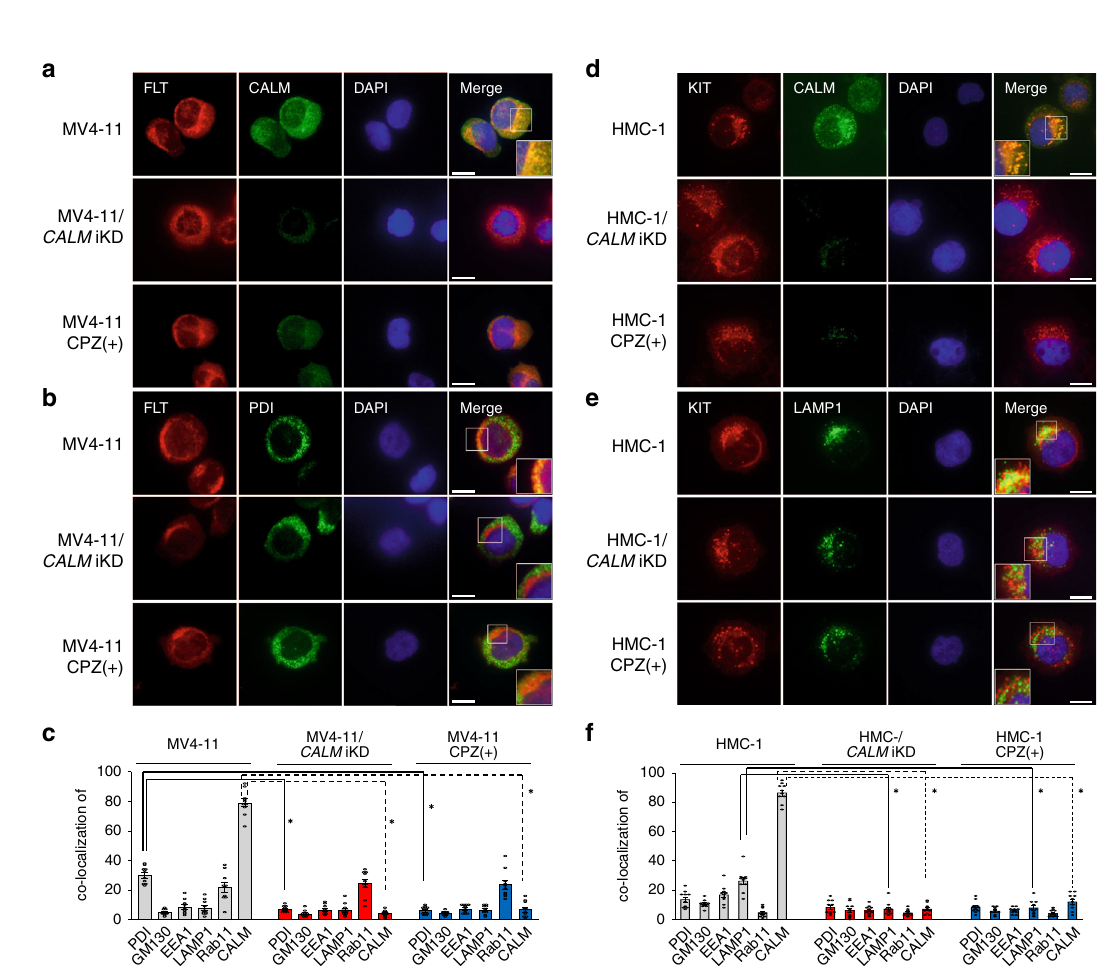
Fig. 4 CALM depletion perturbs the intracellular localization of MT-RTKs. a Parental, CALM iKD, and 18 h CPZ-treated MV4-11 cells were subjected to immuno fl uorescence microscopy. The cells were co-stained with the anti-FLT3 Ab (red), anti-CALM Ab (green), and 4 ′ ,6-diamidino-2-phenylindole (DAPI) (blue). Scale bars, 20 µ m. The right lower panels show regions with higher magni fi cation. Images are representative of three independent experiments. b Parental, CALM iKD, and 18 h CPZ-treated MV4-11 cells were co-stained with the anti-FLT3 Ab (red), anti-protein disul fi de isomerase (PDI) Ab (green), and DAPI (blue). Scale bars, 20 µ m. The right lower panels show regions with higher magni fi cation. Images are representative of three independent experiments. c The graph bars show the percentages of co-localization of FLT3 with PDI, Golgi matrix protein 130 (GM130), early endosome antigen-1 (EEA1), lysosome-associated membrane protein-1 (LAMP1), Rab11 and CALM. Results (%) represent the means ± SEM from ten cells. One-way ANOVA multiple comparisons with Bonferroni correction, * p < 0.0001. d Parental, CALM iKD, and 24 h CPZ-treated HMC-1 cells were subjected to immuno fl uorescence microscopy. The cells were co-stained with the anti-KIT Ab (red), anti-CALM (green) Ab, and DAPI (blue). Scale bars, 20 µ m. Regions with higher magni fi cation are shown in left lower panels. Images are representative of three independent experiments. e Parental, CALM iKD, and 24 h CPZ-treated HMC-1 cells were stained with the anti-KIT Ab (red), anti- LAMP1 Ab (green), and DAPI (blue). Scale bars, 20 µ m. Regions with higher magni fi cation are shown in left lower panels. Images are representative of three independent experiments. f The graph bars show the percentages of co- localization of KIT with PDI, GM130, EEA1, LAMP1, Rab11 and CALM with the means ± SEM from ten cells. One-way ANOVA multiple comparisons with Bonferroni correction, * p <